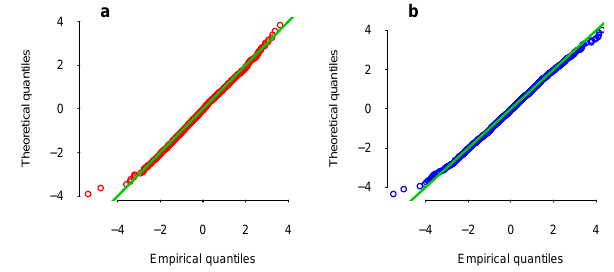
Figure 3. QQ plots of the standardised increments, i.e. the ratio of the first differences in the δ 18 O measurements and estimated stan- dard errors of increments for (a) GISP2 and (b) GRIP. The unusual values correspond to very large differences in consecutive pairs of δ 18 O 20